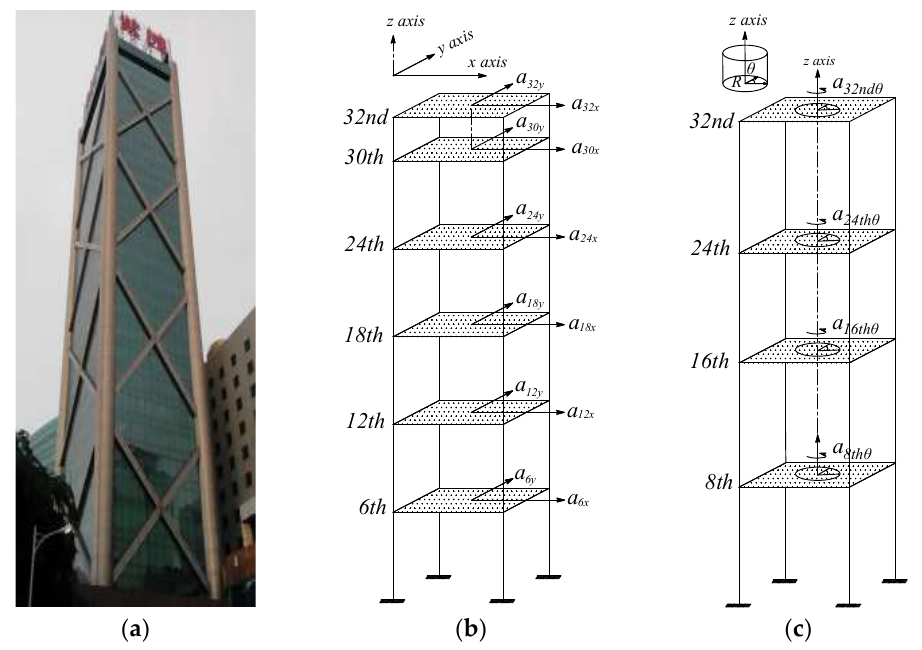
Figure 3. Overview of the measured building, translational and torsional measured points. ( a ) The measured building; ( b )Translational measured points; ( c ) Torsional measured points.